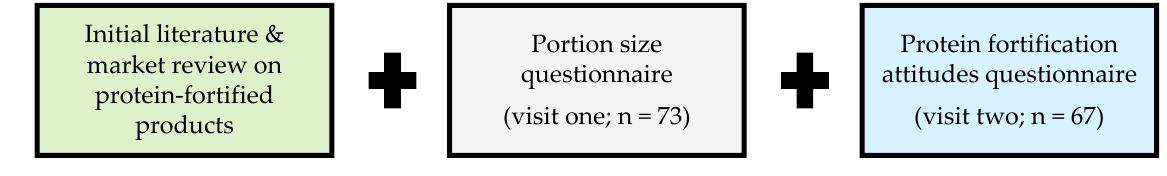
Figure 1. Study overview.